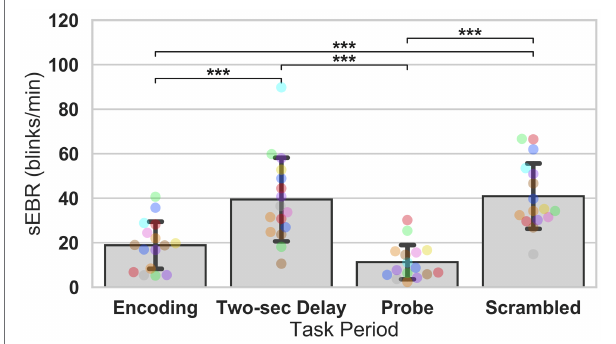
FIGURE 3 | ANOVA test of sEBR across task periods in Experiment 1. Bar plots show task period on the x-axis and sEBR (blinks/min) on the y-axis. Delay period sEBR was significantly greater than Encoding and Probe sEBR. Scrambled sEBR was also significantly greater than Encoding and Probe sEBR. Error bars depict 95% confidence interval. Each colored circle represents an individual participant; some colors may be presented twice in one bar due to limited primary colors available for display. Values of p were adjusted for comparing a family of 4. *** p < 0.001.